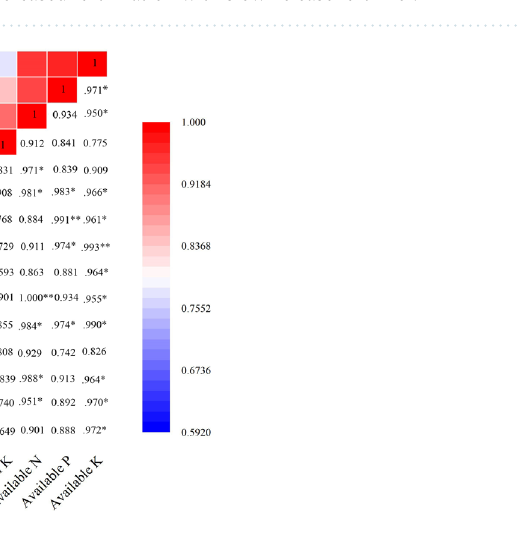
Figure 7. Heat map of Pearson’s correlation coefficient matrix between soil enzyme activity and soil nutrients. Urease 1, Catalase 1, Sucrase 1 represent soil enzymes during the first harvest. Urease 2, Catalase 2, Sucrase 2 represent soil enzymes during the second harvest. Urease 3, Catalase 3, Sucrase 3 represent soil enzymes during the third harvest. The values in the figure are Pearson’s correlation coefficient. * and ** denote correlation coefficients that are significant at p < 0.05 and 0.01 level, respectively. Heat map of Pearson’s correlation coefficient matrix was produced by OriginPro 2019b